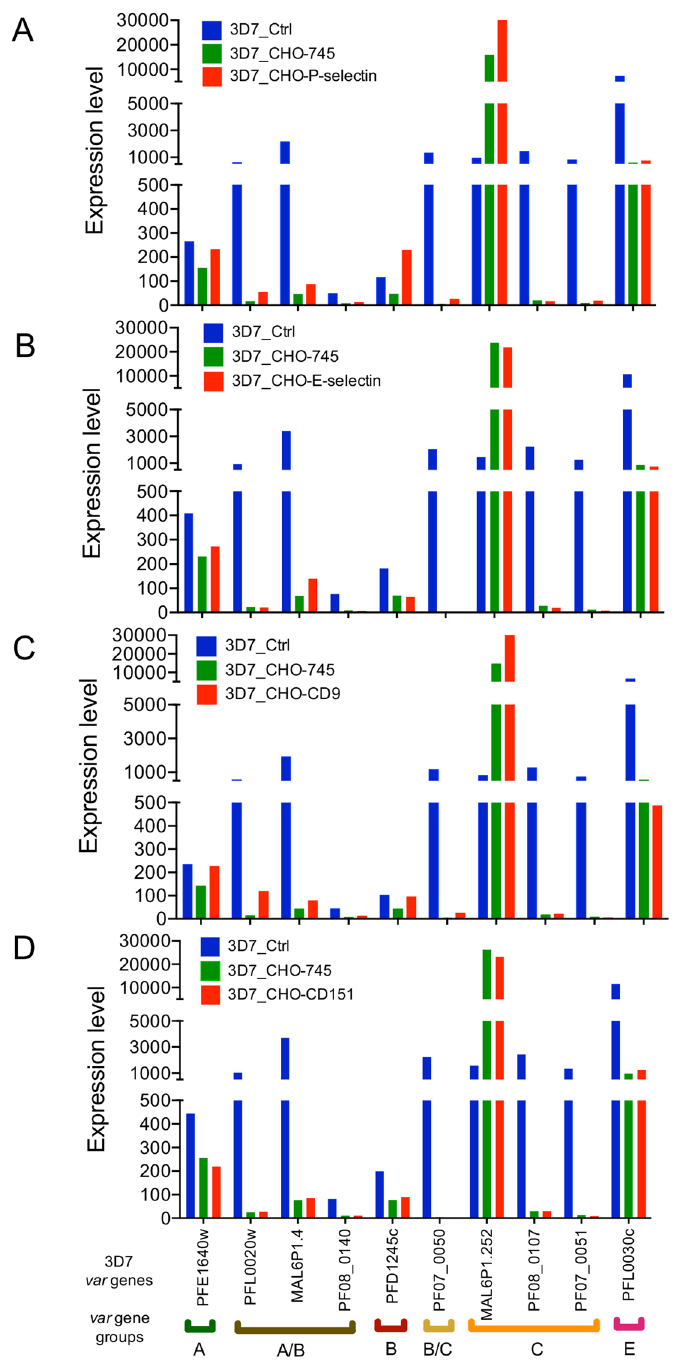
Figure 6. Enrichment of a P. falciparum 3D7 population for selectin- and tetraspanin-binding parasites. The expression of a selected set of var genes in parasite populations enriched for parasites binding to P-selectin ( A ), E-selectin ( B ), CD9 ( C ) or CD151 ( D ), in comparison with long-term cultured 3D7 parasites (3D7_Crtl) and a 3D7 population enriched for parasites binding to CHO-745 cells (3D7_CHO-745) (expression level is defined as average of the normalized read